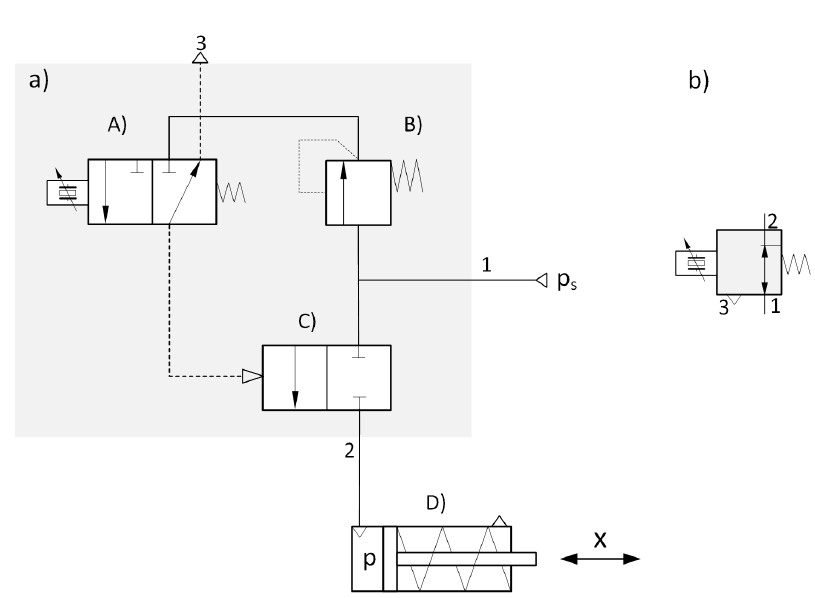
Figure 4. Block schematics of the experimental set-up for the investigation of the basic features a single-action actuator. ( a ) electro-pneumatic transducer; ( b ) schematic symbol. Notations: ( A ) piezo-pilot valve; ( B ) pressure regulator; ( C ) pneumatic booster; and, ( D ) single action pneumatic actuator.